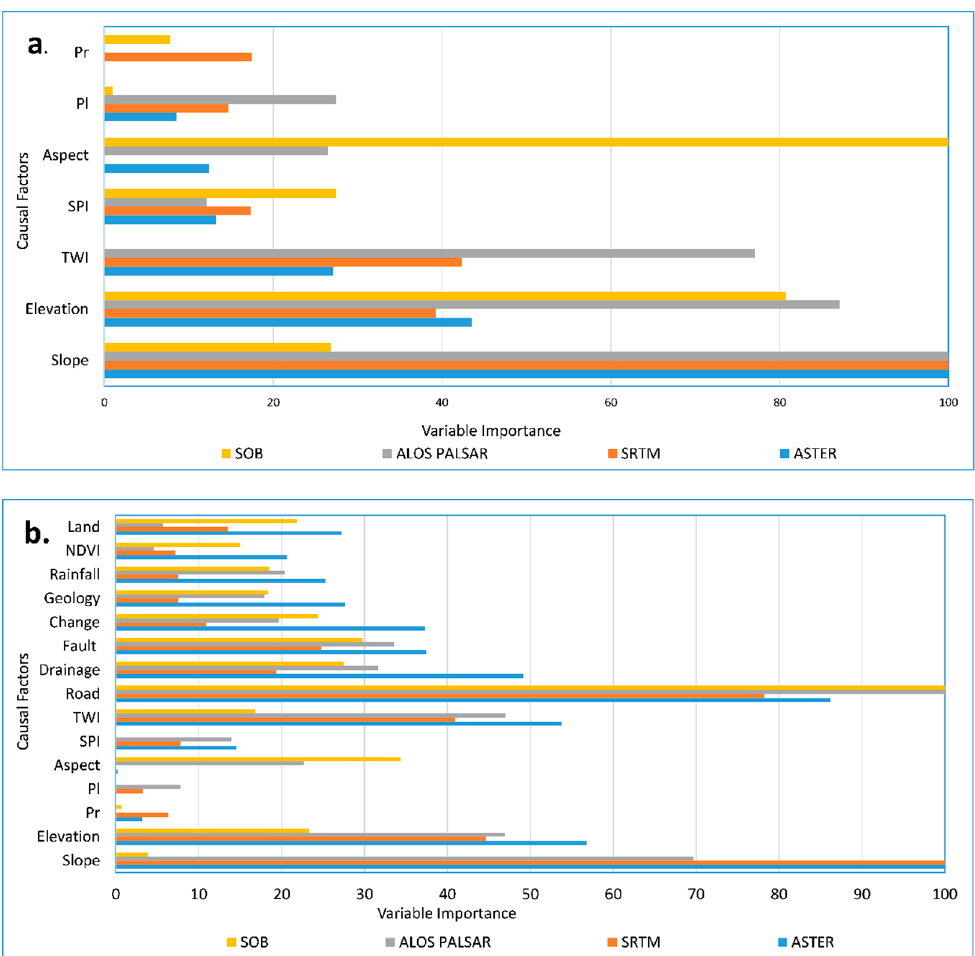
Figure 4. Variable importance plots of random forest model: ( a ) Digital Elevation Model (DEM)based causal factor (7) used in the models. ( b ) All (15) factors used in the models. Pl = plan curvature; Pr = profile curvature; LC = land use / land cover; LLC = land use / land cover change; DF = distance from the fault lines; DD = distance from the drainage networks; DR = distance from the road